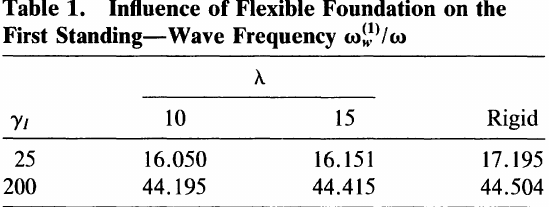
Table 1. Influence of Flexible Foundation on the First Standing-Wave Frequency